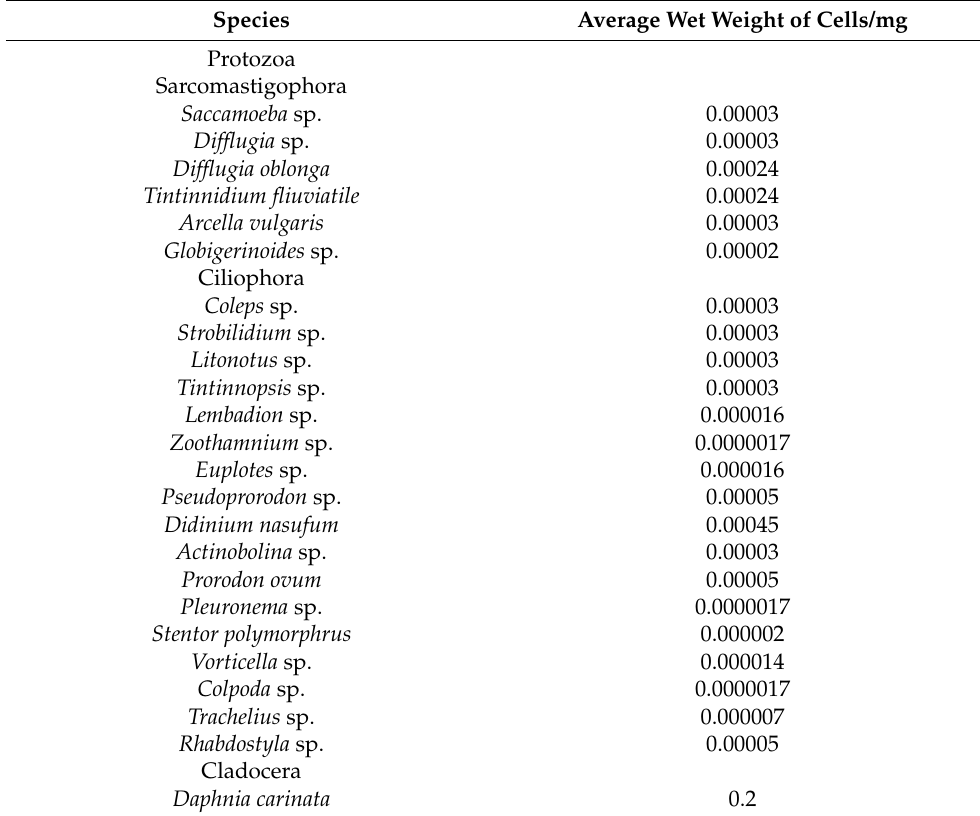
Table A3. Phytoplankton in each enclosure with the average wet weight.